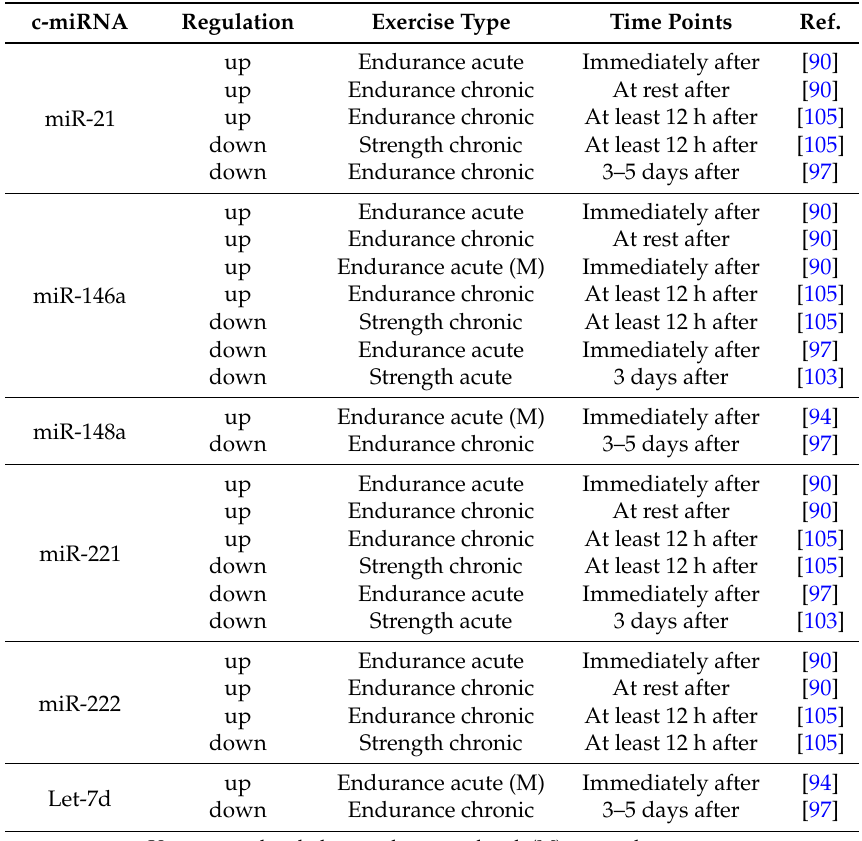
Table 2. circulating microRNAs (c-miRNAs) with differential expression profiles in plasma or serum depending on type of exercise and sample